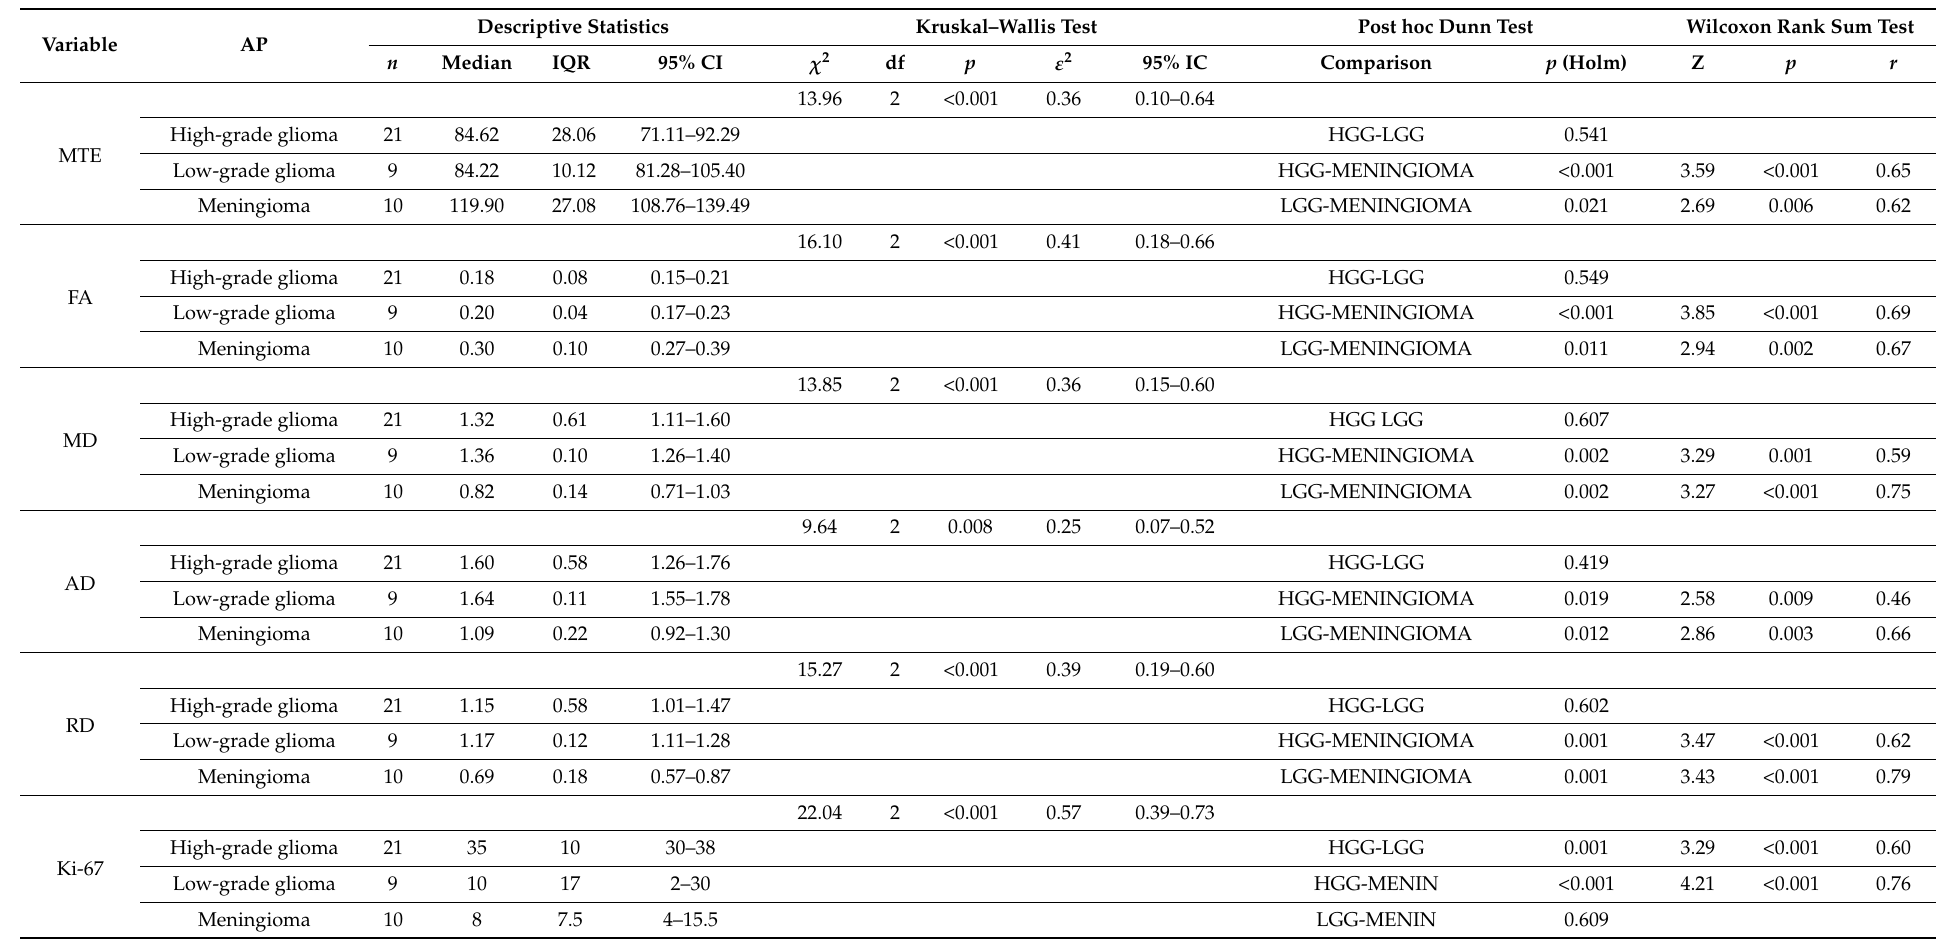
Table 2. Univariate analysis of quantitative variables of the whole tumor region and histopathological